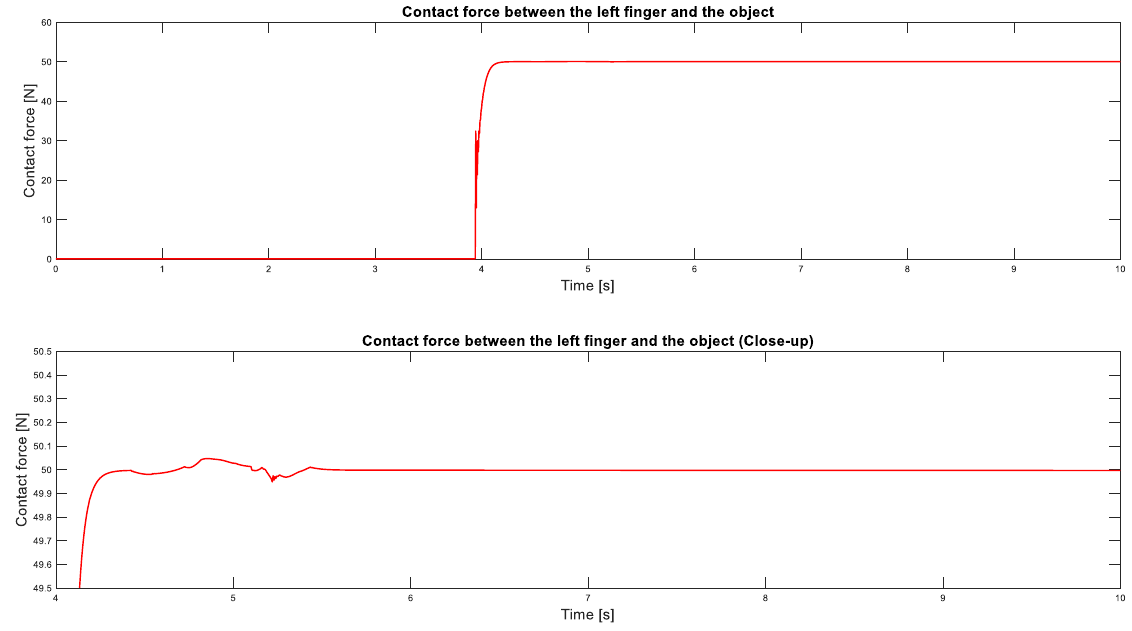
Table 2. Force controller parameters. Source: own.